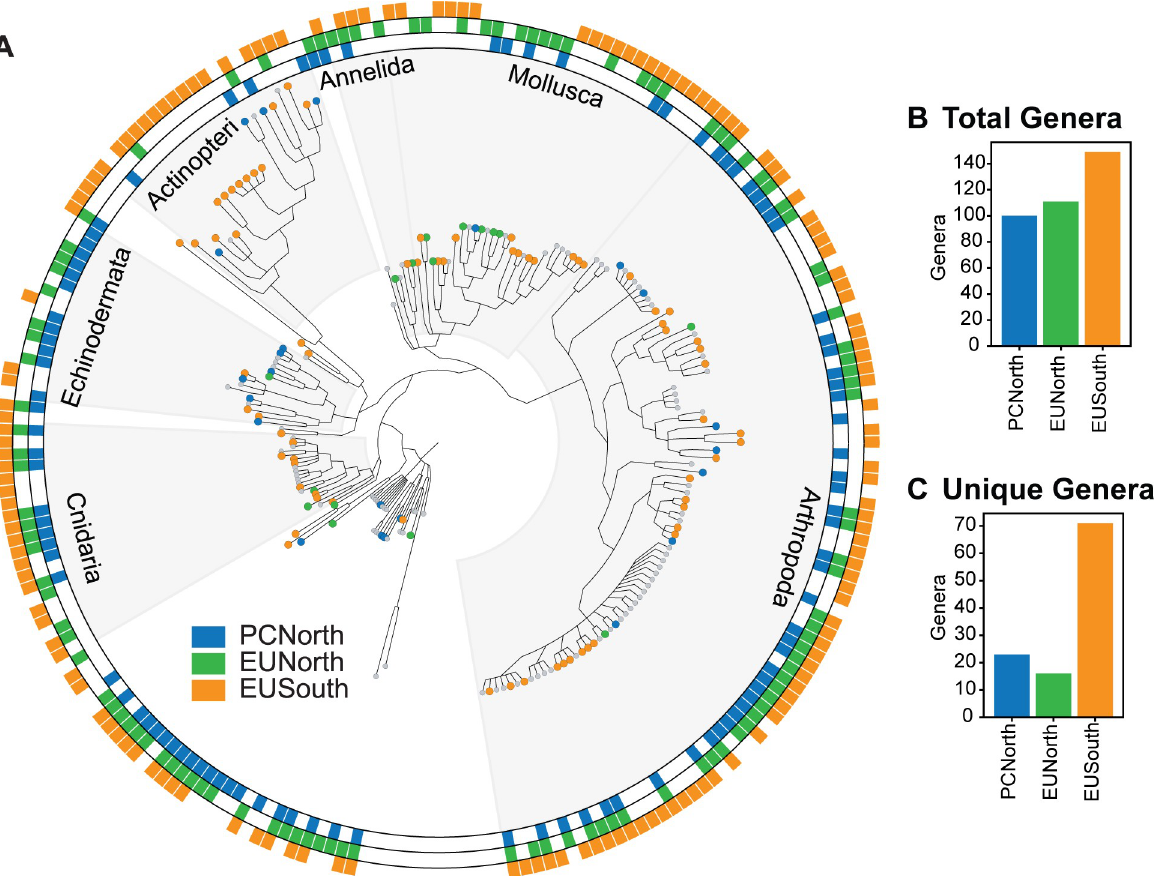
Fig 6. Detection of genera across regions. Detection of genus-level annotations within the COI Banzai dataset across the three regions: PCNorth (blue), EUNorth (green), and EUSouth (yellow). (A) Cladogram of genera detected. A colored bar within the ring indicates presence of OTUs annotated to that genus within the dataset. A blue, green, or yellow circle at the leaf of the tree indicates that genus was found only within that region. Highly abundant phyla are labeled. (B) Bar plot showing number of total genera found within each region. (C) Bar plot showing number of unique genera found within each